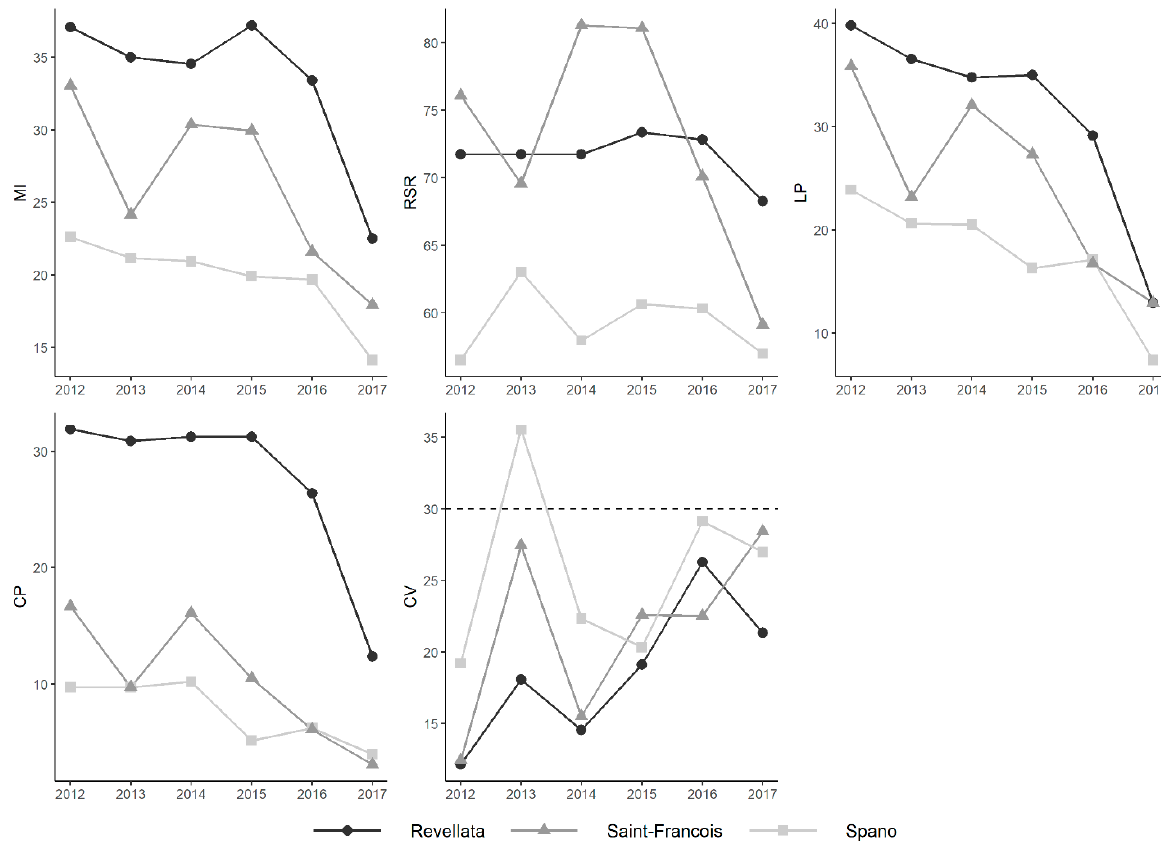
Figure 3. Temporal evolution of FAST results (CP, LP, MI, RSR) between 2012 and 2017 in the Saint-Francois, Spano, and Revellata zones.